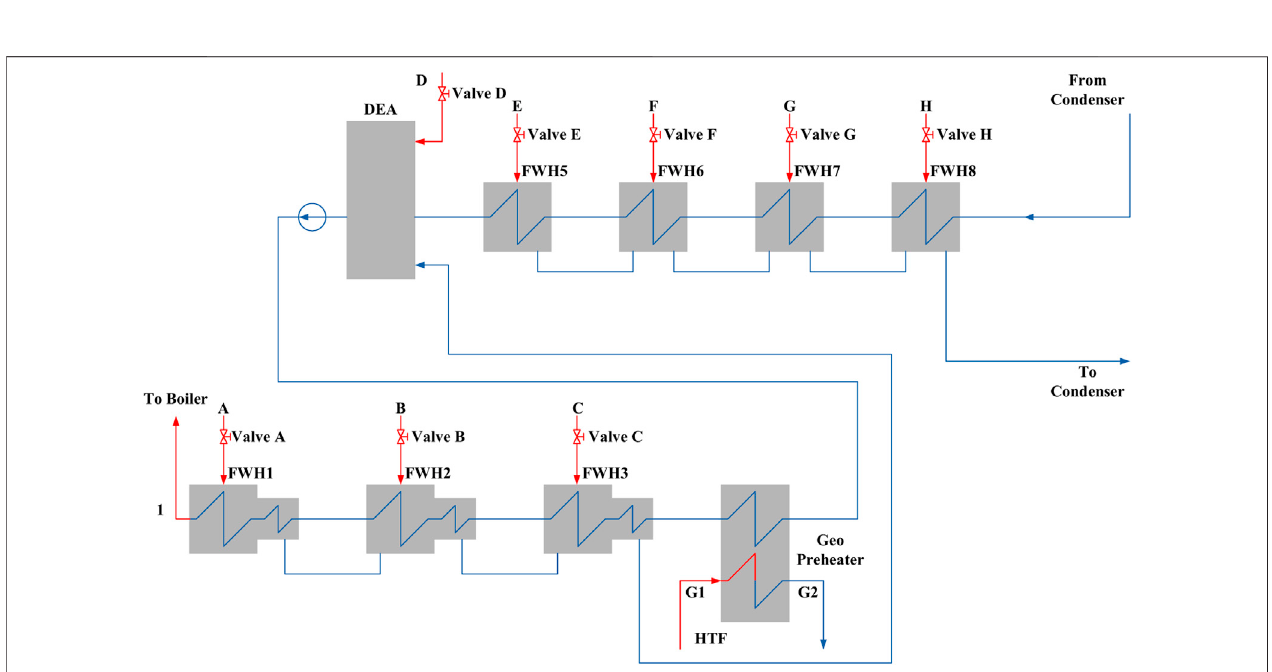
FIGURE 3 | Schematic diagram of Series GAPG plant feedwater heater system.